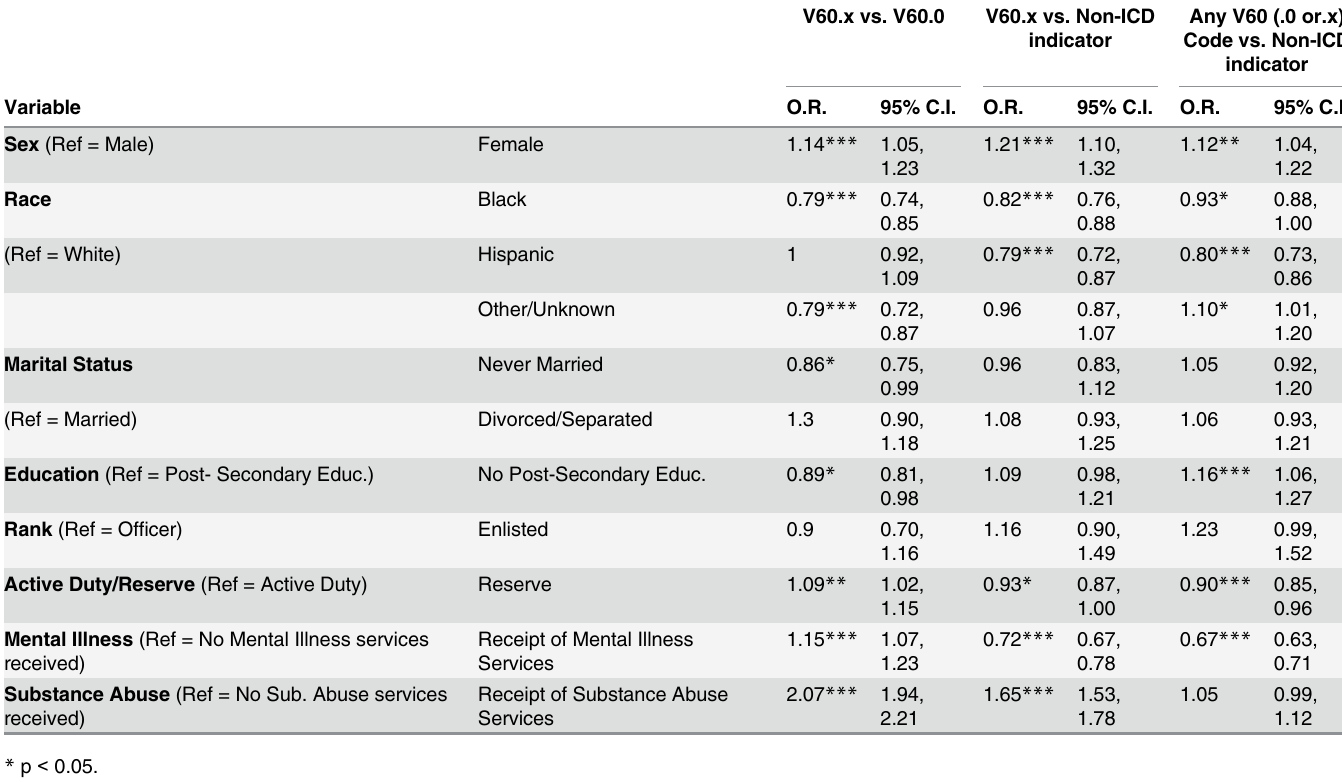
Table 6. Results of logistic regression analyses of first administrative indicator of homelessness classification. Note. OR = odds ratio, CI = confidence